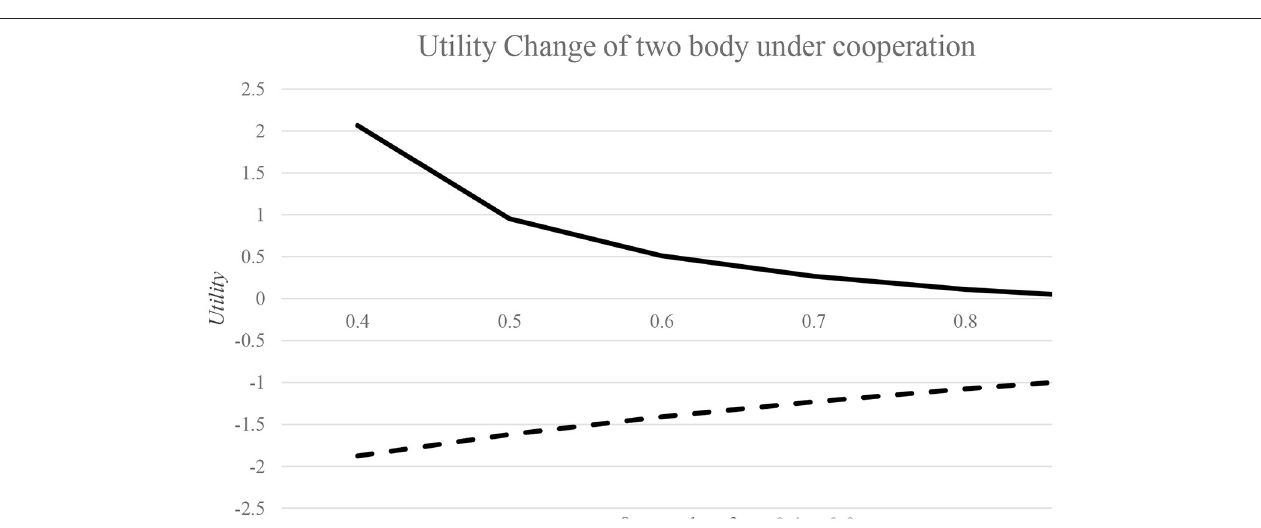
FIGURE 2 | Utility change of two countries in cooperation situation with different β